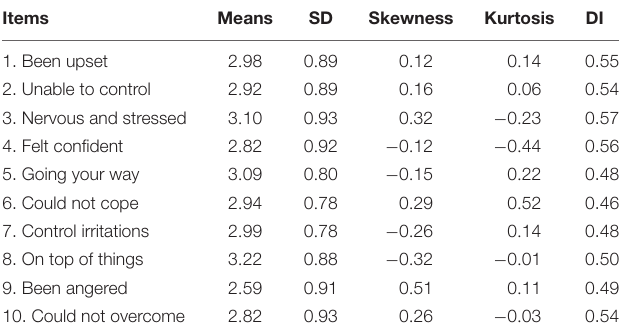
TABLE 1 | Descriptive statistics of the PSS-10.